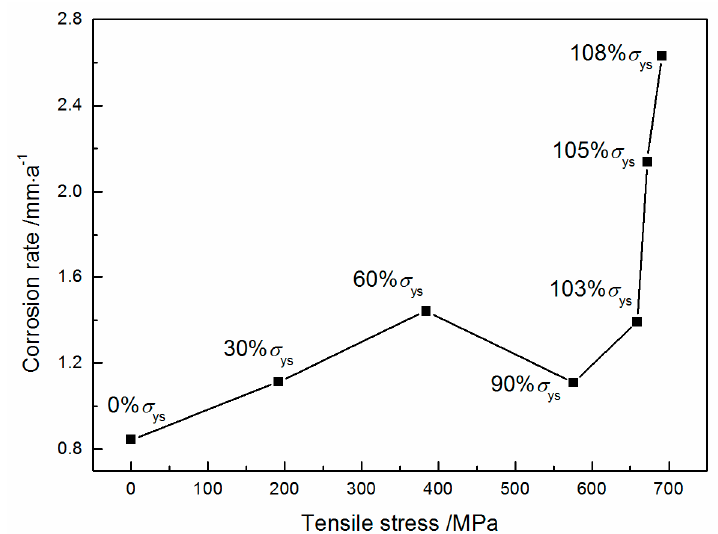
Figure 6. Corrosion rates of X80 steel exposed to 3.5 wt% NaCl aqueous solution with saturated CO 2 under different elastic and plastic tensile stress at 30 °C by fitting potentiodynamic polarization curves.